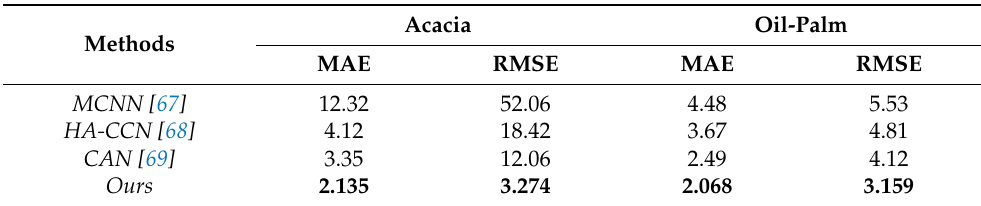
Table 2. The tree counting performance compared with MCNN, HA-CCN, and CAN on acacia and oil-palm